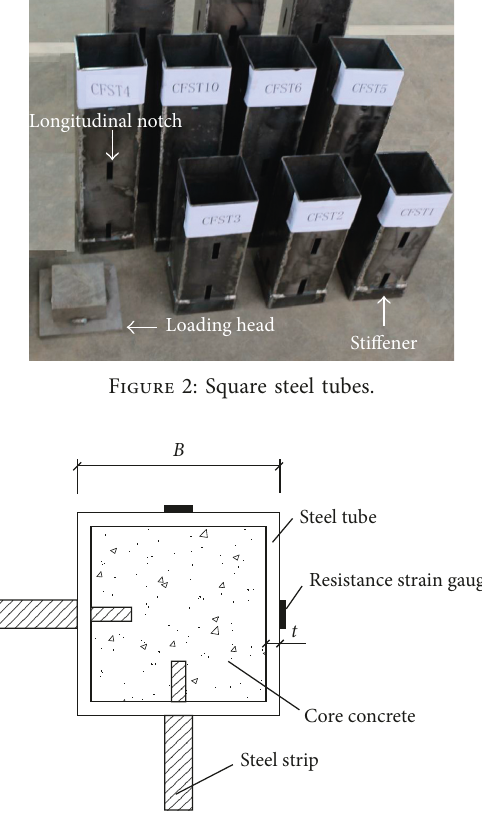
Figure 3: Cross-sectional area of specimens.